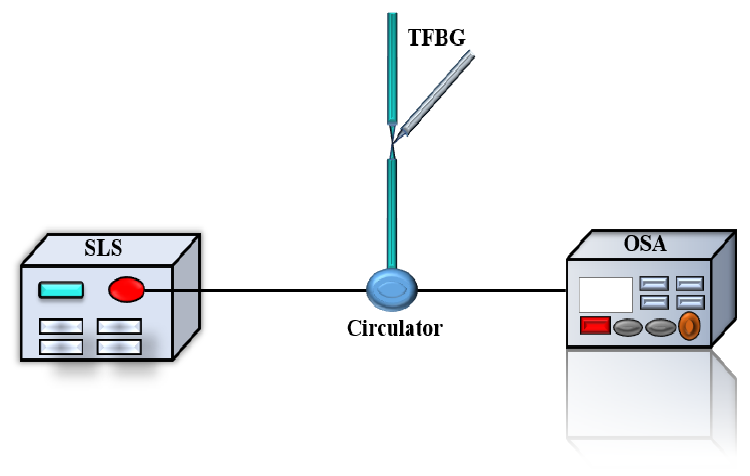
Figure 3. Schematic diagram of the experimental setup for the inclination measurement system.